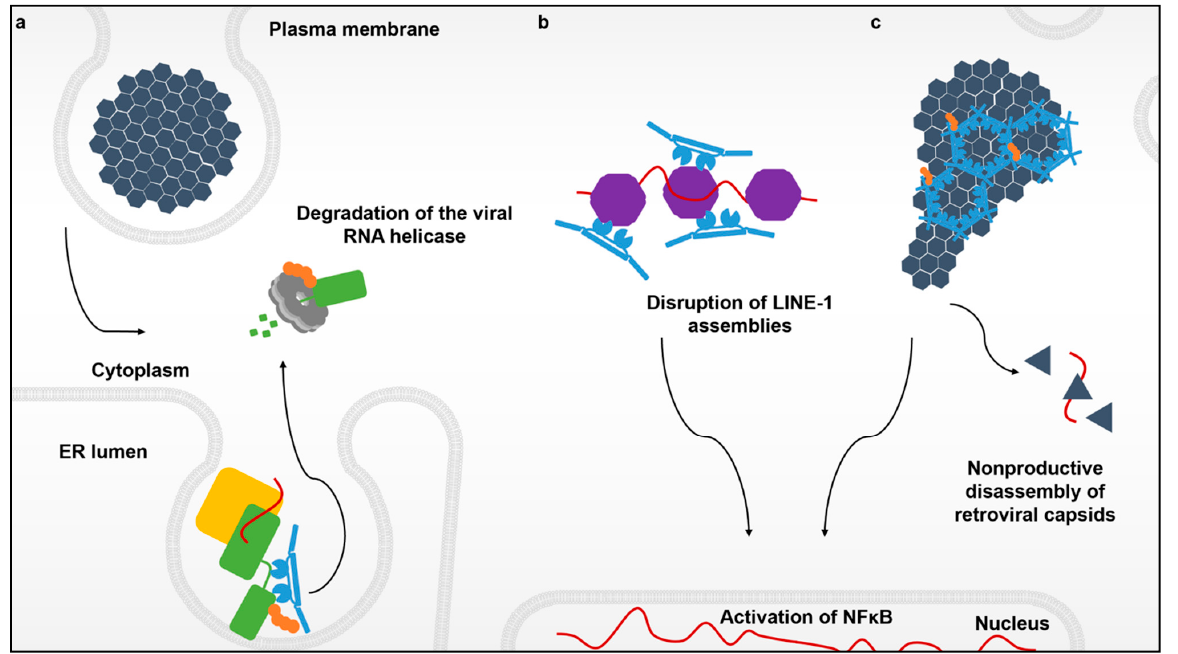
Figure 1. The various interactions between TRIM5 α and its targets. Flaviviruses enter the cell cytoplasm via endocytosis and create replication complexes anchored to modified membranes of the endoplasmic reticulum. ( a ) Recognition of the active flavivirus replication complex (yellow) by TRIM5 α (blue) that leads to the ubiquitination (orange) and degradation of the viral RNA protease-helicase (green) via the proteasome (light grey). ( b ) Innate immune sensing and disruption of cytoplasmic assemblies of the retroelement LINE-1 (purple). ( c ) The retroviral capsid lattice (black) coated by hexagonal assemblies of TRIM5 α . These higher-order TRIM5 α oligomers not only induce premature uncoating of the retroviral genome, but also create a platform to promote a TRIM5 α -mediated antiviral state via induction of NF- κ B signaling.